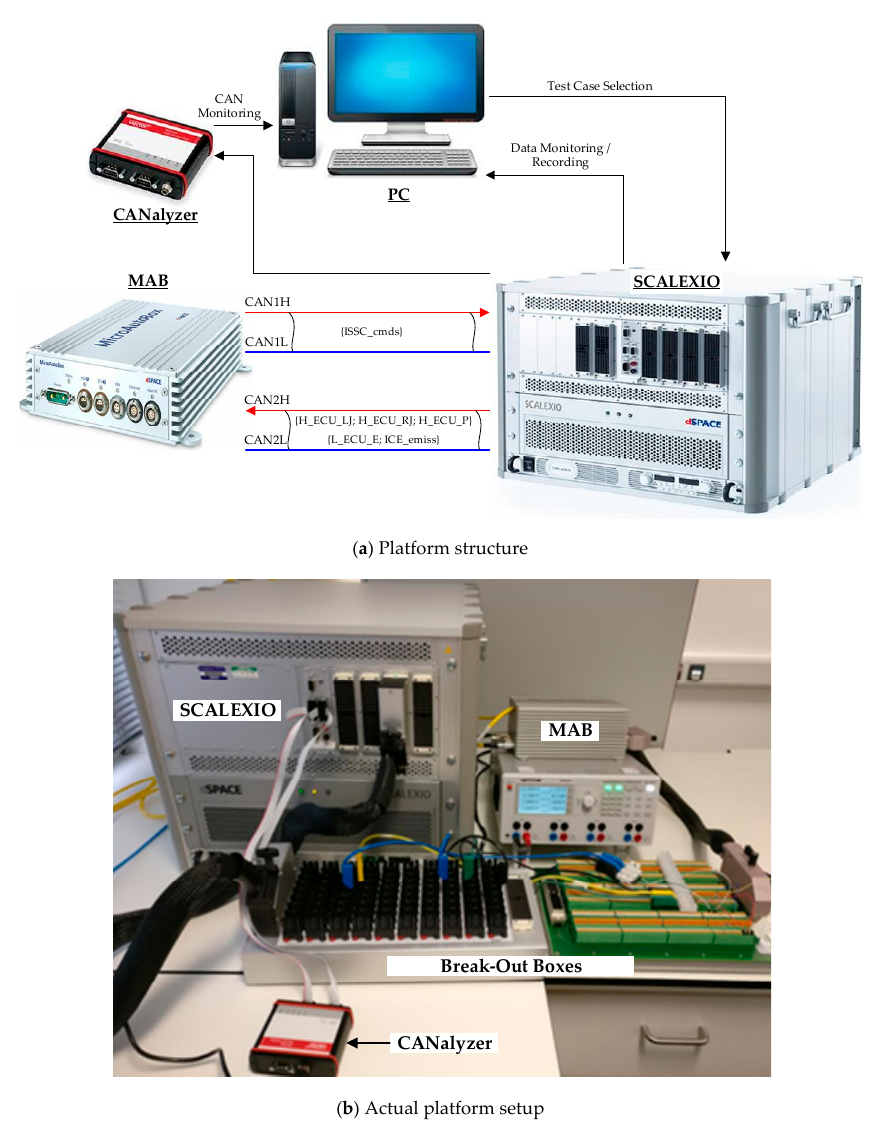
Figure 8. Hardware-in-the-loop test platform.